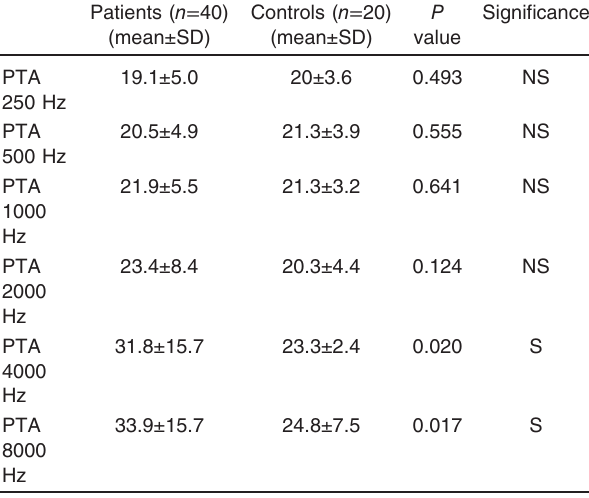
Table 2 Mean±SD of hearing threshold levels of rheumatoid arthritis patients and the control group in the left